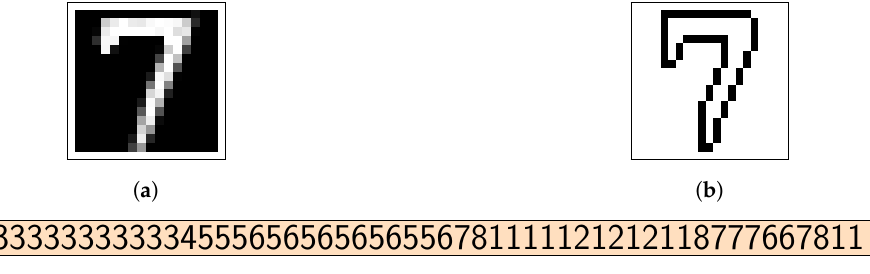
Figure 2. Example of a contour and string codification of a sample from the USPS corpus representing the digit 7. ( a ) Original image; ( b ) Extracted contour; ( c ) String representation using Freeman Chain Codes.